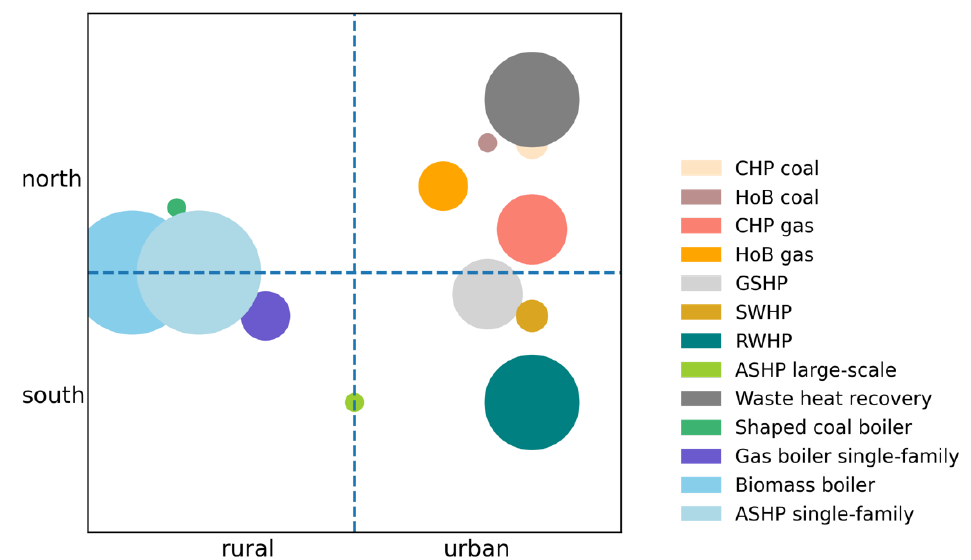
Figure 6. Relative feasibility and market-penetrating potential for building heating solutions.